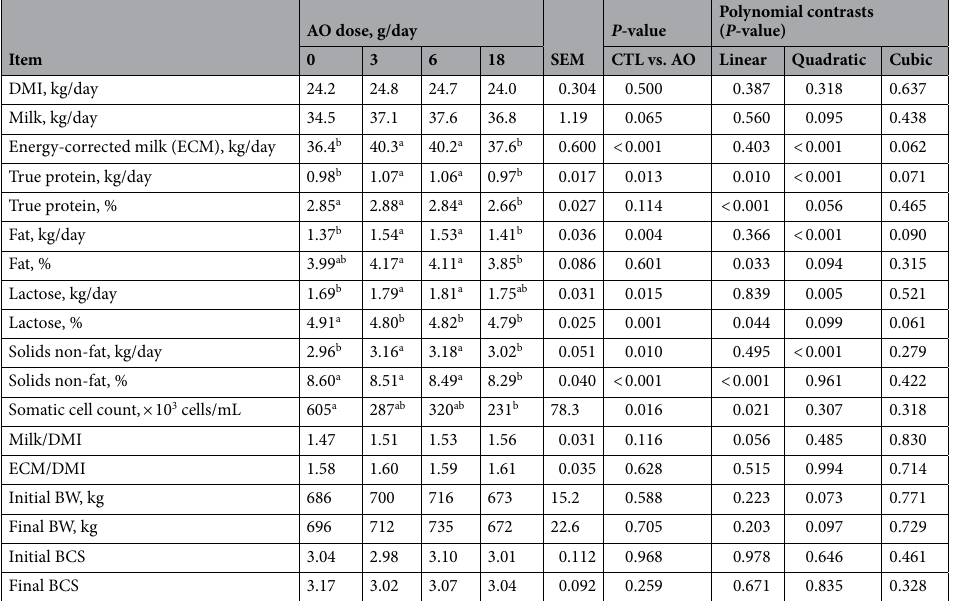
Table 4. Dry matter intake (DMI), yields of milk and milk components, and feed-use efficiency of lactating Holstein cows fed different doses of an Aspergillus oryzae (AO) postbiotic under heat stress conditions. Data are least squares means (LSM) ± SEM. BW body weight, BCS body condition score, CTL control treatment. a,b Superscripts denote AO dose differences among LSM (0.05 < P ≤ 0.10). CTL vs. AO denotes contrast between CTL and AO